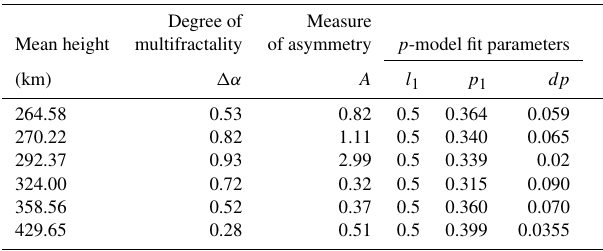
Table 1. Multifractal analysis measures for the first experiment: the time series at mean heights are listed in the first column, the second column shows the degree of multifractality ( (cid:49)α ), and the third col- umn gives the measure of asymmetry ( A ). Columns 4 to 6 list the p -model fit parameters, l 1 , p 1 , and dp